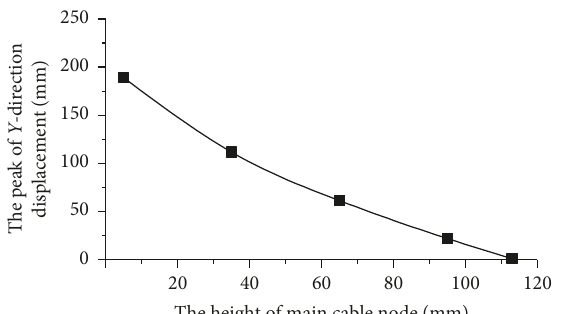
Figure 11: The peak Y -direction displacement vs. the height of the main cable node.